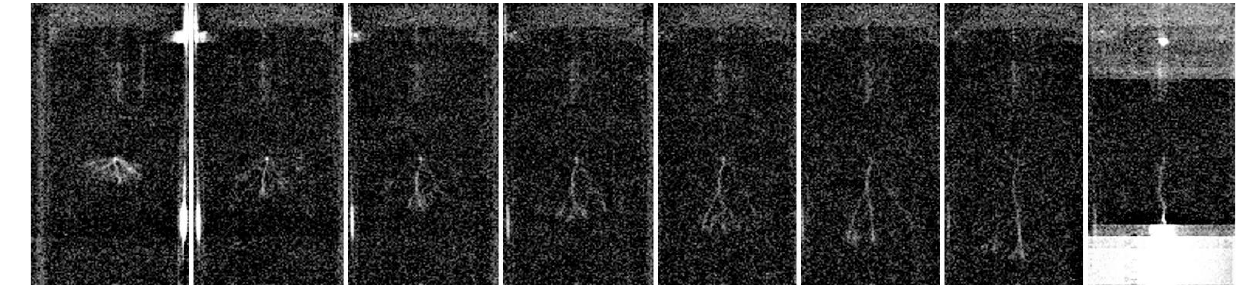
Figure A1. 1% DEA in cyclohexane, positive polarity, 228 kV. 4.16 µs between frames, Time-To- Breakdown (TTB) ≈ 40 µs.